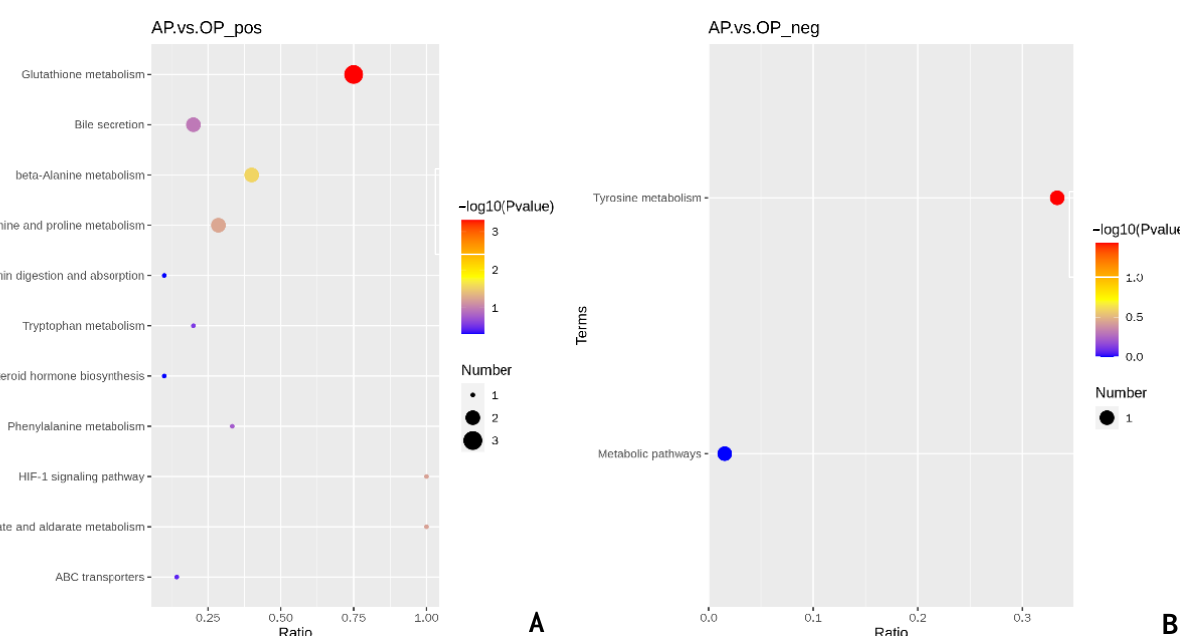
Table 6. A comparison of the concentrations of metabolites in pancreas tissue from yak calves fed alfalfa hay or oat hay.